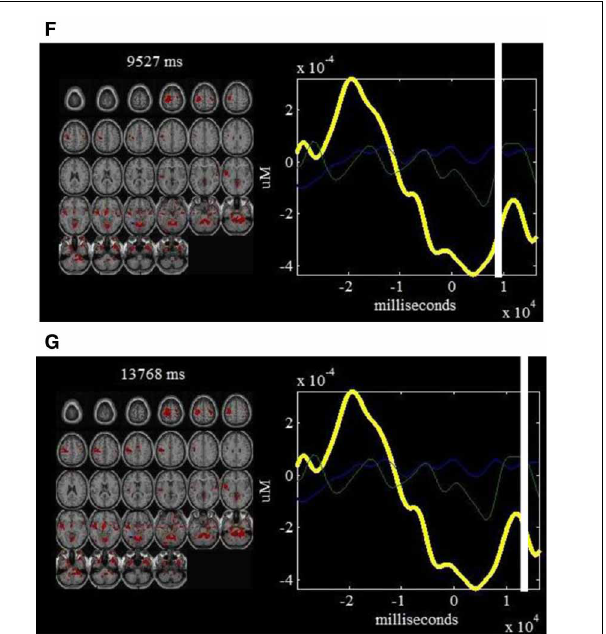
FIGURE 6 | (cid:2) HbR components and fMRI “snapshots”: on the left of each window is shown a linear combination of the fMRI maps that are well-correlated with finger tapping tasks (composite ICs 1 and 3), weighted by the (cid:2) HbR part of the components at a specific point in time. On the right of each window is shown the estimated (cid:2) HbR components that are correlated with right finger tapping tasks. The time courses for IC1 (in blue) and IC3 (in green) are also plotted on the right of each window. Such a display provides a dynamic way to visualize the brain activity at different time points: − 13460 ms (A) , − 10452ms (B) , − 1082ms (C) , 1747ms (D) , 4045ms (E) , 9527ms (F) and 13768ms (G)